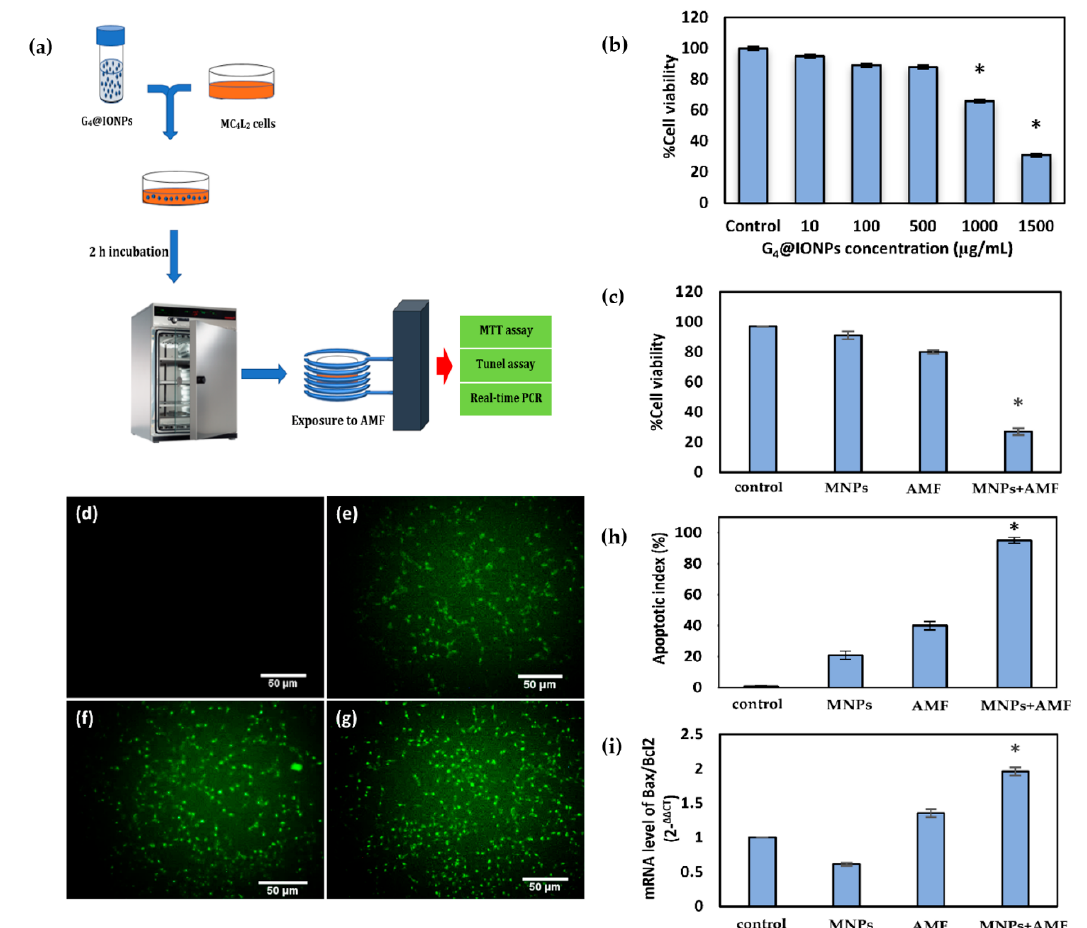
Figure 3. ( a ) Schematic illustration of magnetic hyperthermia in vitro experiments. 2 × 105 MC 4 L 2 cells